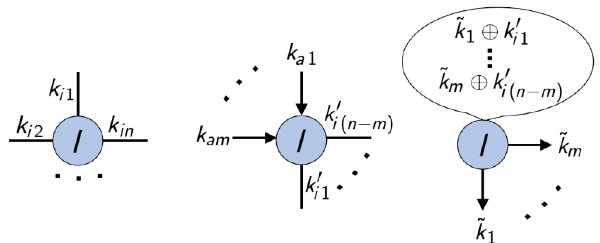
FIG. 4. The procedure for splitting keys during quantum secure flooding. The left diagram depicts the initial neighbor- hood of user I , which shares keys with n other users. The middle diagram shows the user when it is contacted during step (4) of the quantum secure-flooding protocol. The user receives m keys and has n − m remaining keys. The right diagram shows the node having split its keys according to the received ordering and announcing these keys XOR ed with the remaining n − m